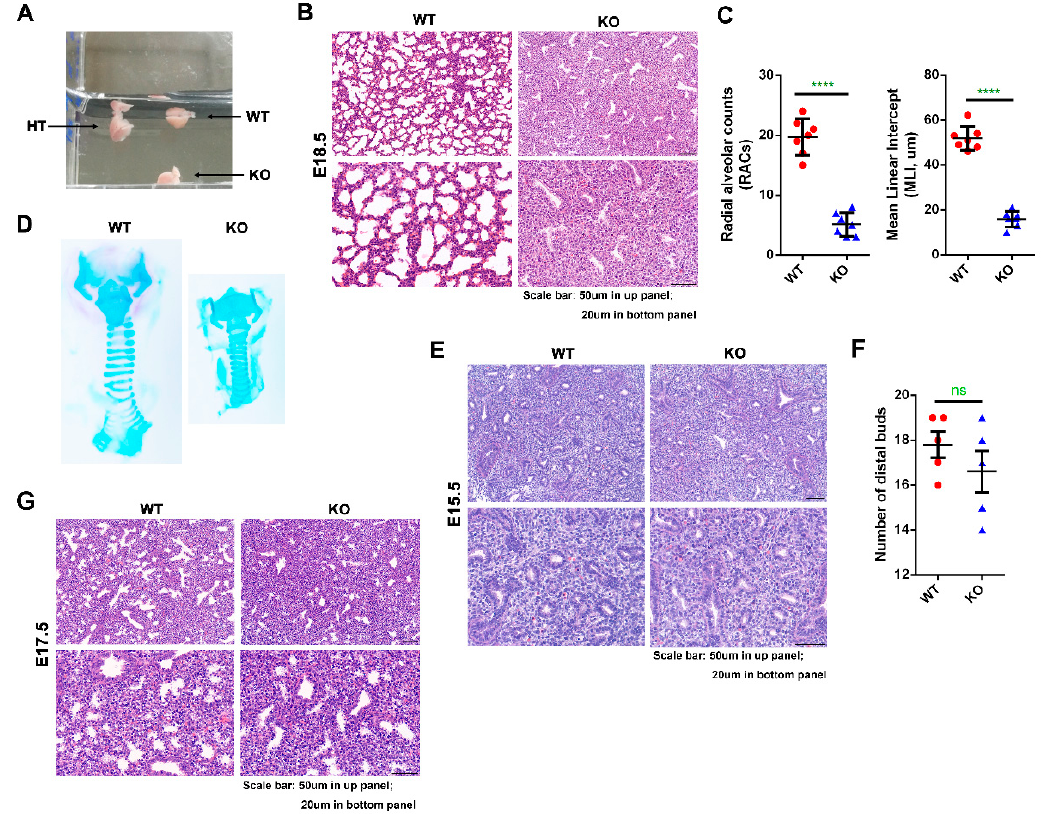
Figure 3. Kub3 deletion results in pulmonary atelectasis during embryonic development. ( A ) Floating assay for E18.5 lungs. WT, HT and KO lungs were dissected and put in PBS buffer. WT and HT lungs floated in PBS buffer, but Kub3 KO lungs sank due to a lack of air inflation. ( B ) Representative images of H&E-stained lung sections of WT and KO lungs at E18.5. Scale bar: 50 µ m in the upper panel; 20 µ m in the bottom panel. ( C ) Morphometric analysis of lung interalveolar distance measured by mean linear intercept (MLI) and number of distal alveolar estimated by radial alveolar counts (RACs) in WT and KO lungs at E18.5 ( n = 7 per group; **** p < 0.0001). ( D ) Alcian blue–Alizarin staining of trachea in the E18.5 lung. The cartilaginous trachea is stained dark blue by Alcian blue. ( E ) Representative images of H&E-stained lung sections of WT and KO lungs at E15.5. Scale bar: 50 µm in the upper panel; 20 µm in the bottom panel. ( F ) Morphometric analysis of the number of distal epithelial buds in E15.5 lungs ( n = 6 per group. p > 0.05, ns: non-significant). ( G ) Representative images of H&E-stained lung sections of WT and KO lungs at E17.5. Scale bar: 50 µm in upper panel; 20 µm in bottom panel.